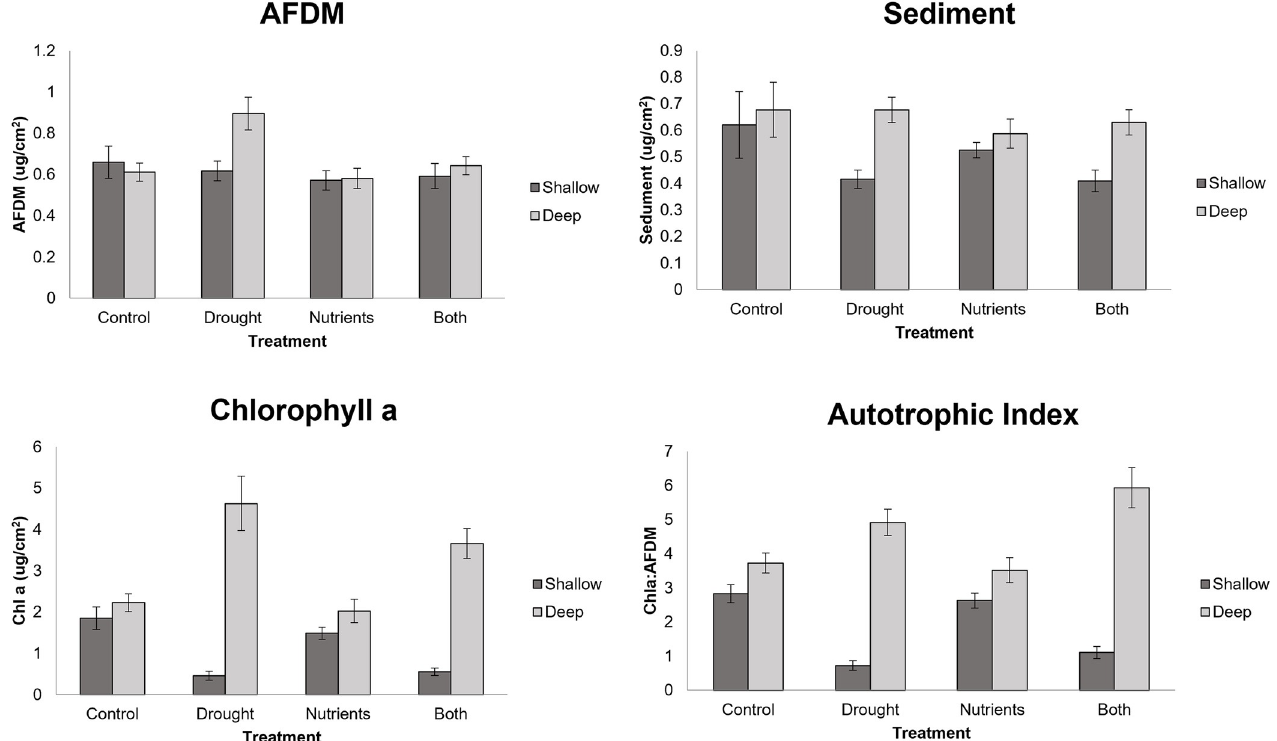
Fig 2. Ash free dry mass (AFDM, top left), Sediment levels (top right), Chlorophyll a (Chl a, bottom left), and Autotrophic Index (bottom right) for shallow and deep habitats. Error bars represent standard error.